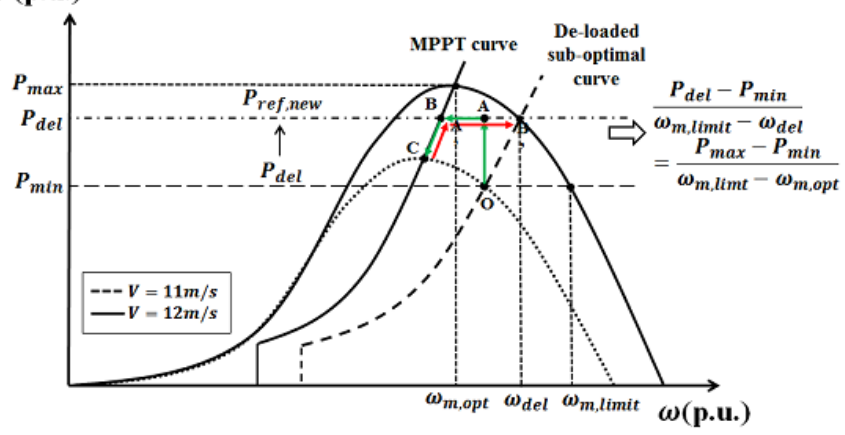
Figure 3. Schematic diagram of the de-loaded (DL) sub-optimal operating power point curve.